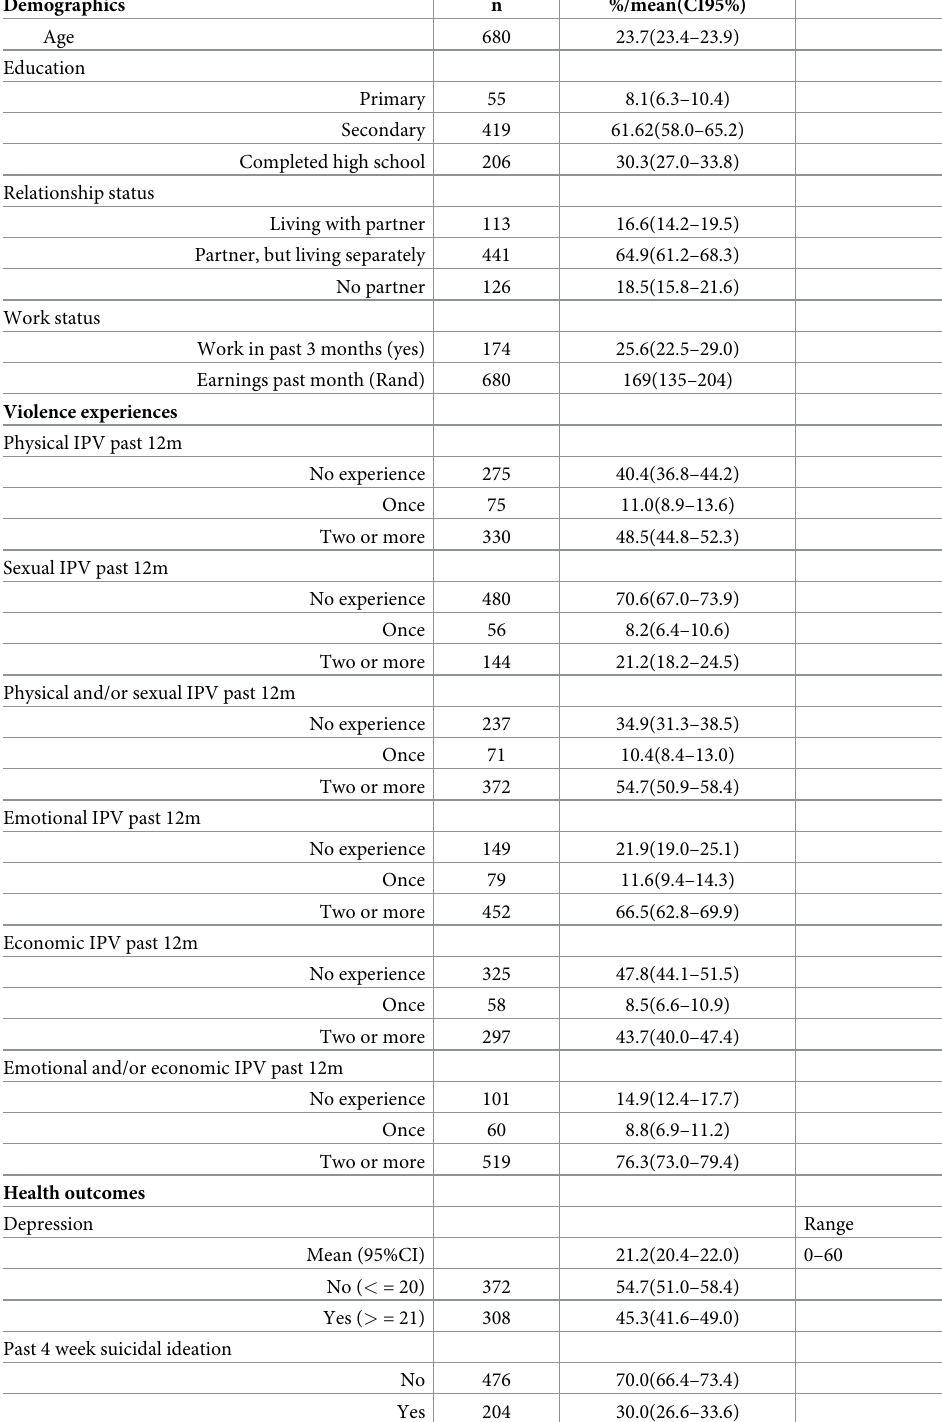
Table 1. Descriptive statistics of sample demographics, IPV experiences and health